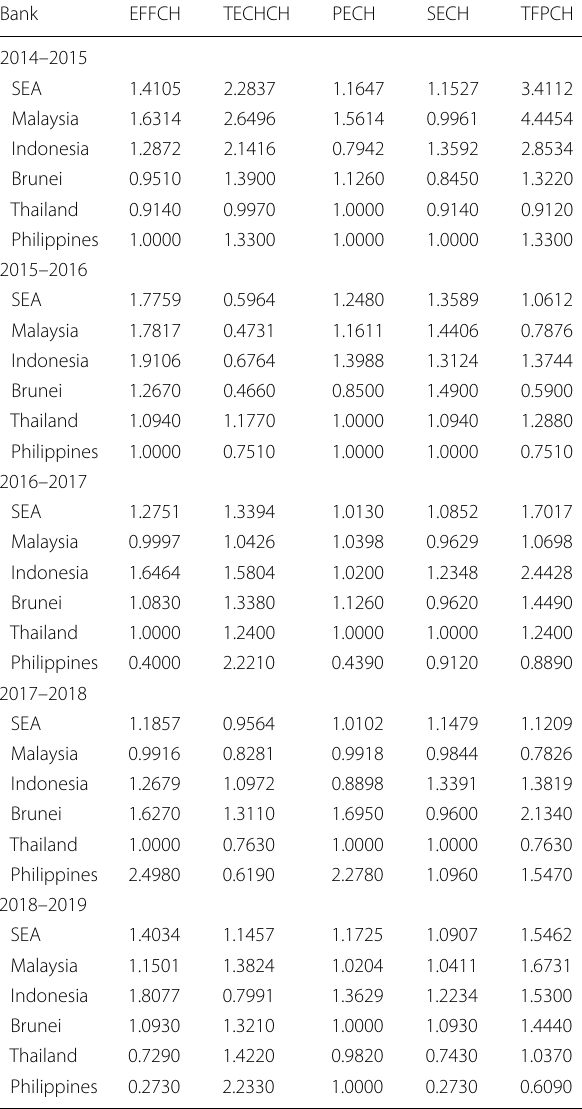
Table 3 Malmquist productivity index results for SEA Islamic